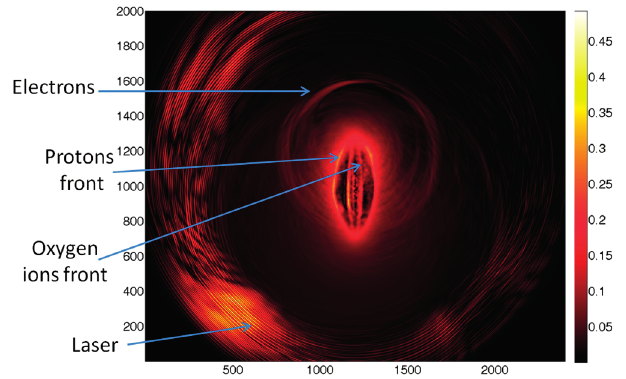
Figure 4. Spatial dependence of the electric field in units of a 0 = 3.4, at 235 fs after the start of interaction of a laser pulse at intensity 2.5 × 10 19 W/cm 2 at 45° irradiation angle.